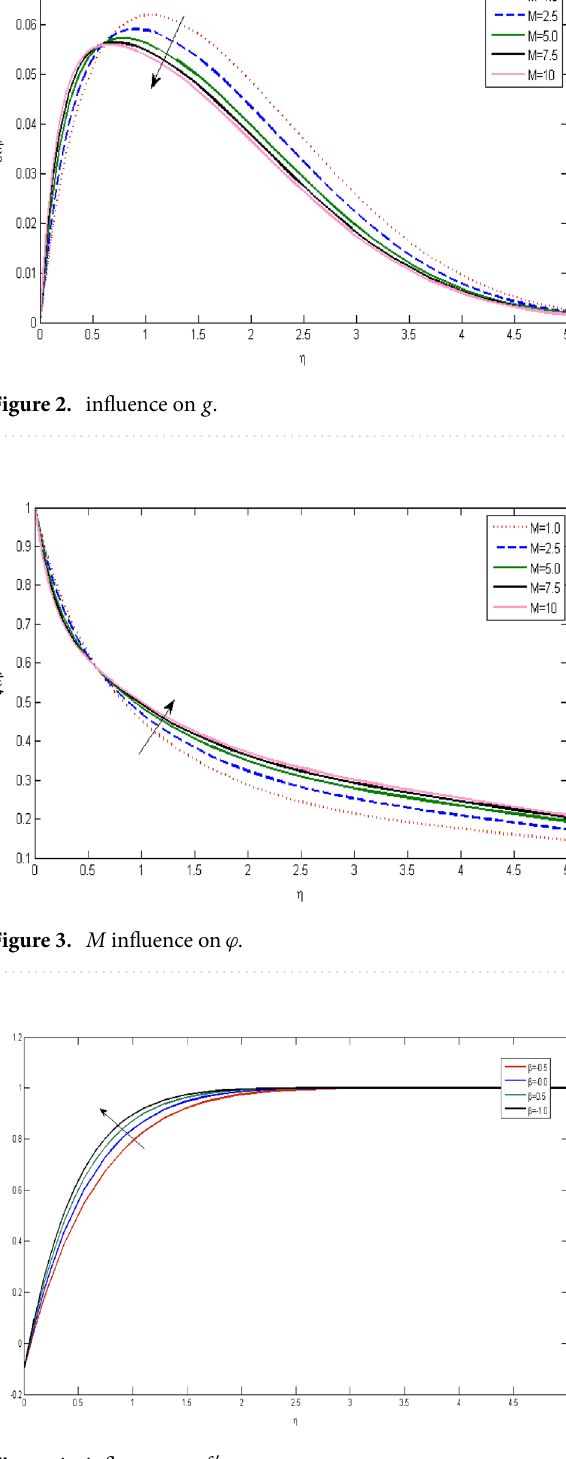
Figure 4. influence on f ′